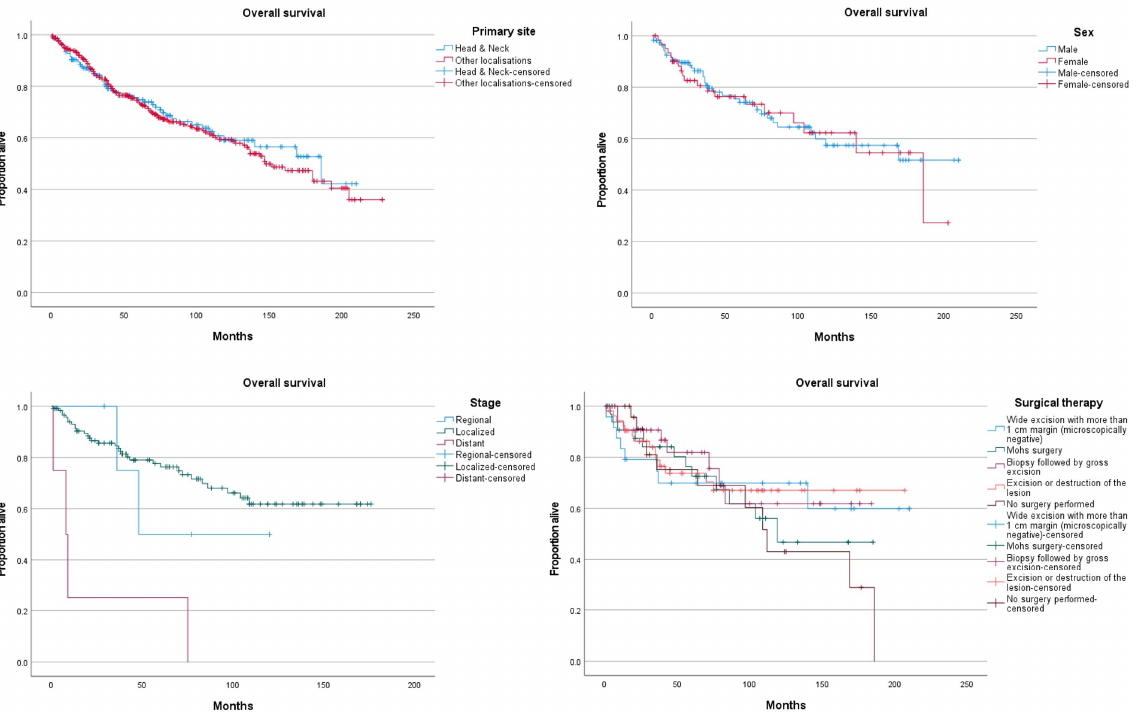
Figure 2. Overall survival curves of head and neck porocarcinoma according to sex, stage, and surgical treatment.